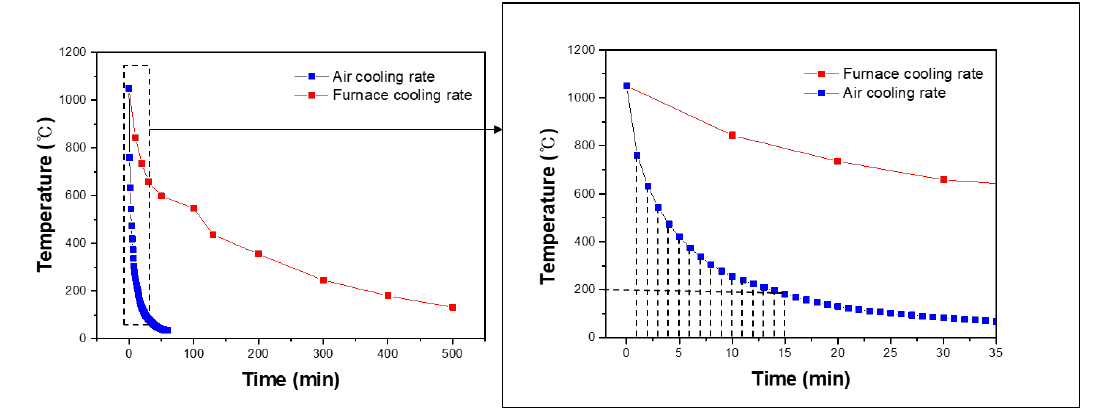
Figure 4. Temperature during air cooling and furnace cooling.